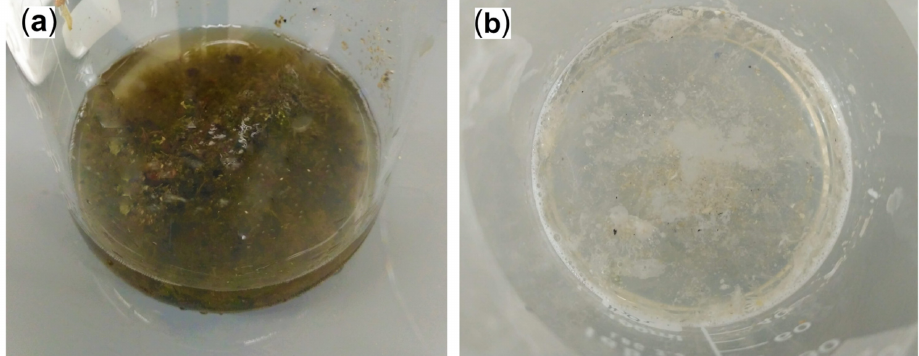
Figure 1. AQ sample, before the test (level 1 of the scale) ( a ) and after one week ( b ) of treatment with H 2 O 2 at 15% ( v/v ) (level 4 of the